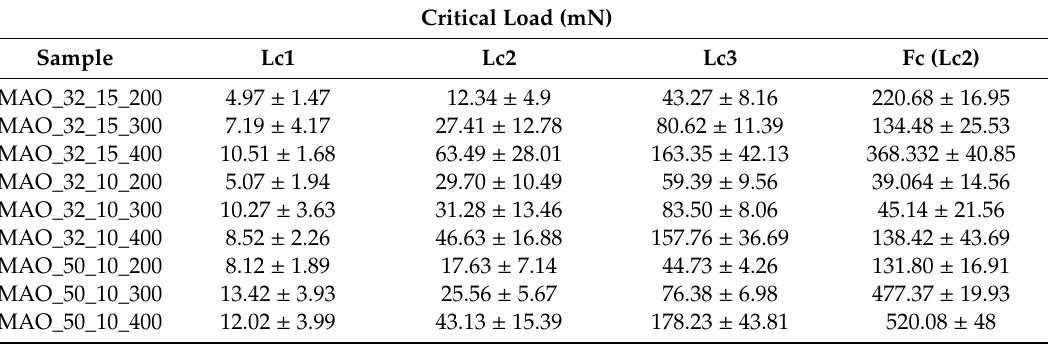
Figure 9. The scratch path with cohesion and adhesion failures after scratch testing ( a – c ), and the relation of friction ( F ), acoustic emission, and penetration depth on load ( L ) with the indicated critical loads (Lc1, Lc2, Lc3) ( a’ – c’ ) of the investigated MAO coatings obtained at various MAO process parameters: MAO_32_15_200 ( a , a’ ), MAO_32_15_300 ( b , b’ ), and MAO_32_15_400 ( c , c’ ) (the presented results are representative for ten analyses of each surface treatment specimens). Table 5. Critical loads and critical friction force caused total delamination (Fc (Lc2)) measured during the scratch test for all MAO coatings samples (the presented results are representative for five analyses of each surface treatment specimens).